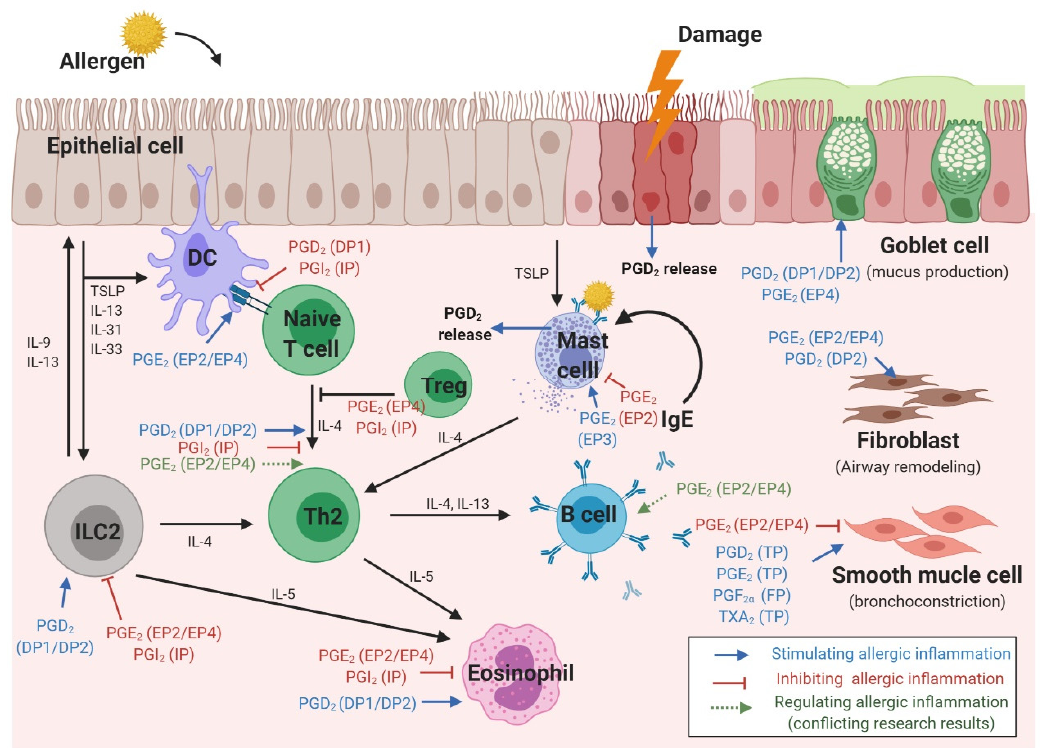
Figure 2. Stimulatory and inhibitory effects of prostaglandins, and their receptors, in different cell types involved in the pathophysiology of respiratory